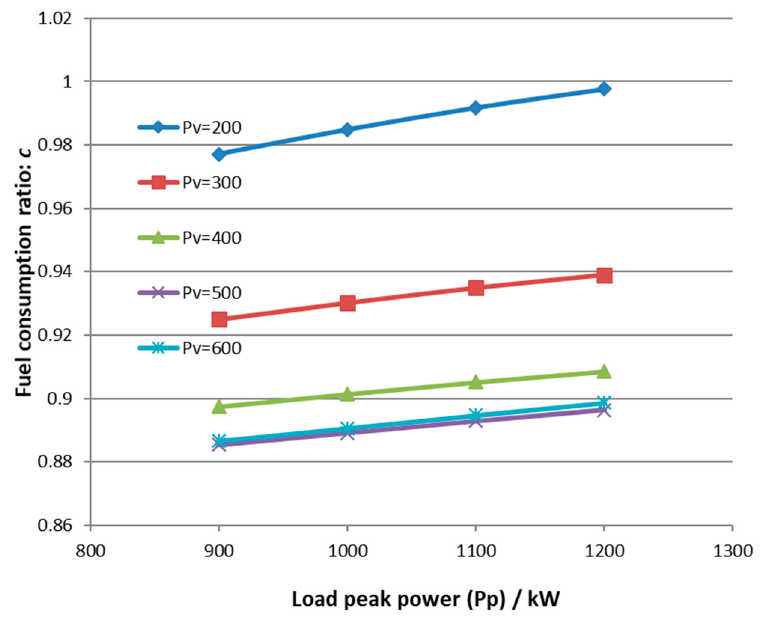
Figure 11. Fuel consumption ratio comparison ( t = 9, η = 0.85, r = r t ).